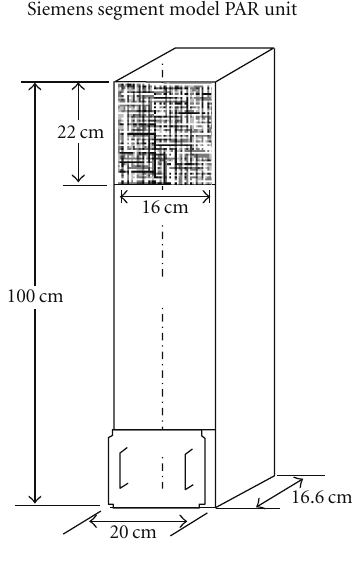
Figure 9: Sketch of PAR